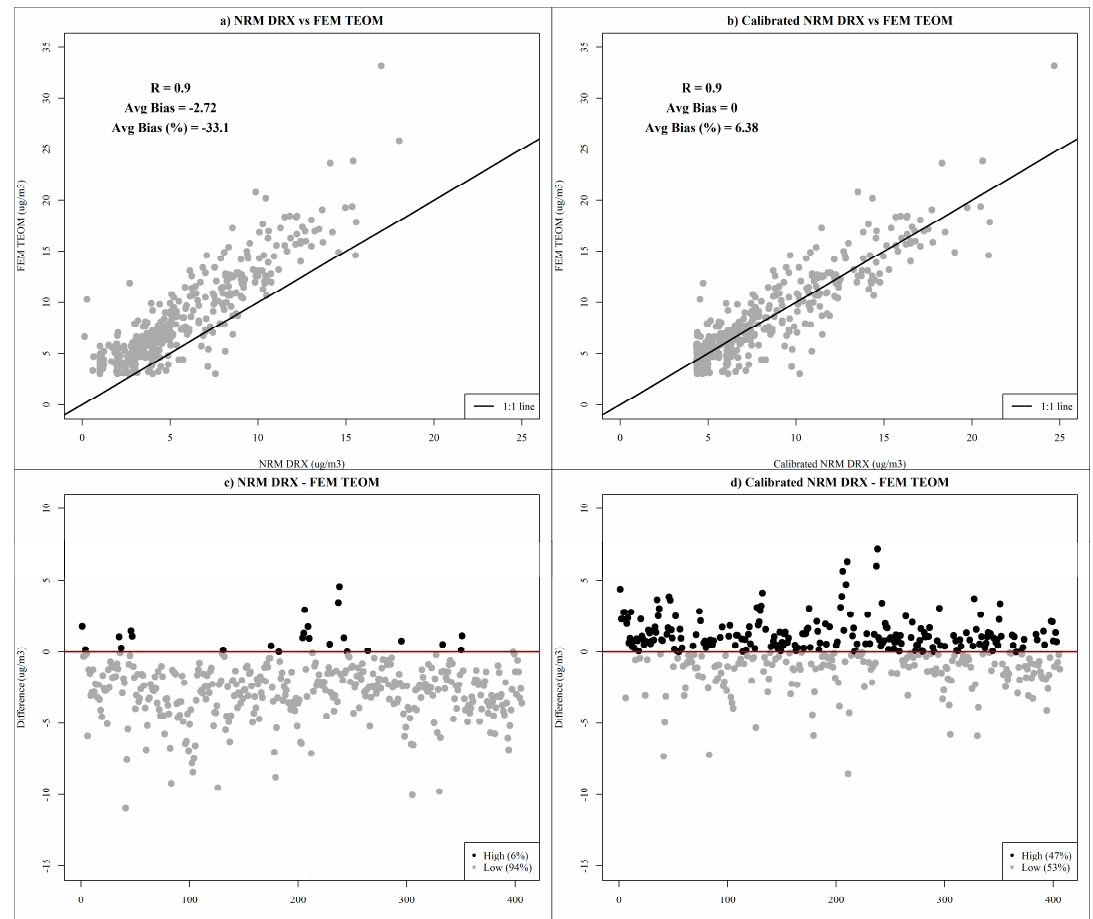
Figure 5. Evaluation plots of our raw data ( a ) and generalized additive model (GAM)-based calibration data ( b ) for hourly PM 2.5 for the NRM (DRX). ( c ) and ( d ) depict difference trends (DT) in hourly data points before and after applying the GAM-based calibration, respectively.